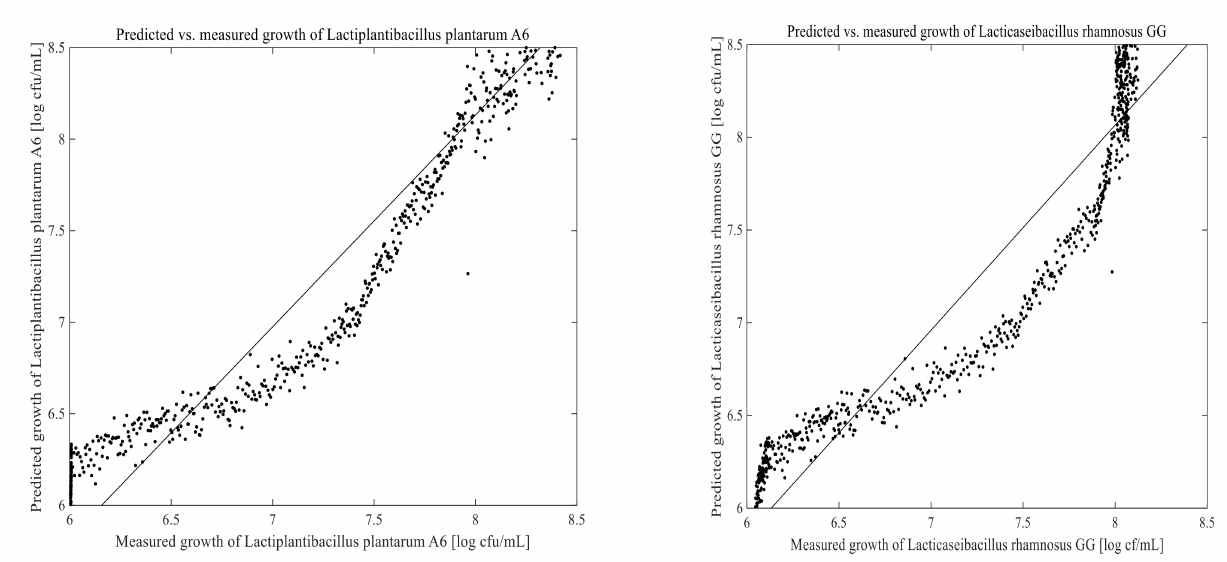
Figure 8. Predicted vs. measured cell growth in the fermentation of 7 g/100 mL of substrate inoculated with mixed strains of 6 log cfu/mL Lactiplantibacillus plantarum A6 and Lacticaseibacillus rhamnosus GG; predicted with partial least-squares regression using six principal components.